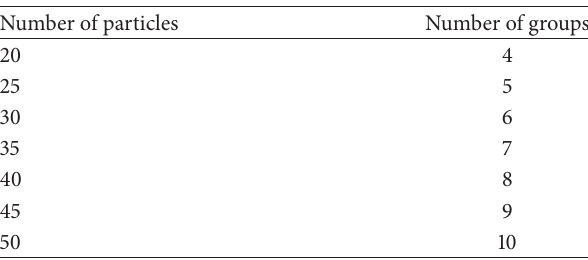
Table 7: Experimental setup for number of